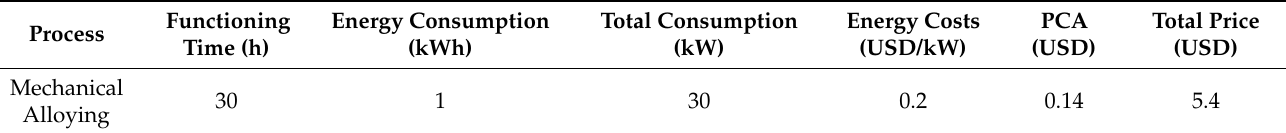
Table 3. Elaboration costs for 100 g of HEA processed by mechanical alloying.